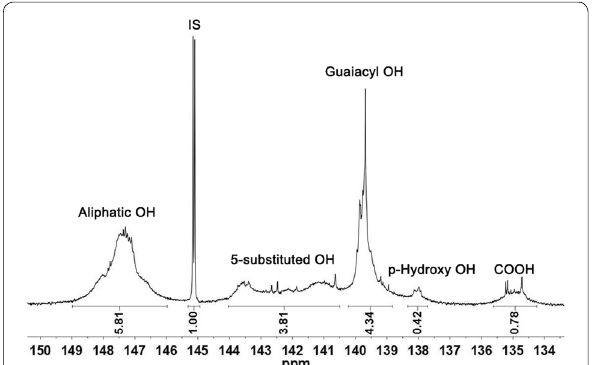
Fig. 1 Quantitative 31 P NMR spectrum of softwood kraft lignin